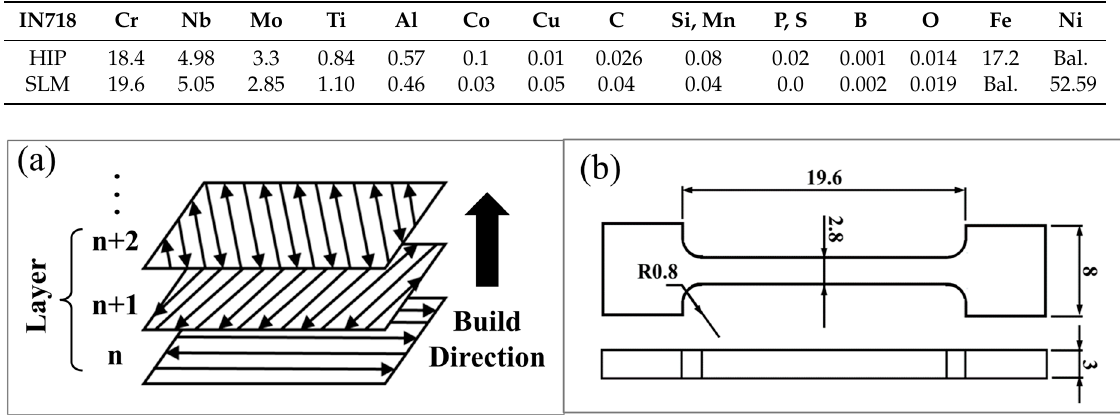
Figure 2. Illustrations of ( a ) scanning strategy of the SLM process and ( b ) dimensions of the mechanical test specimen (mm).